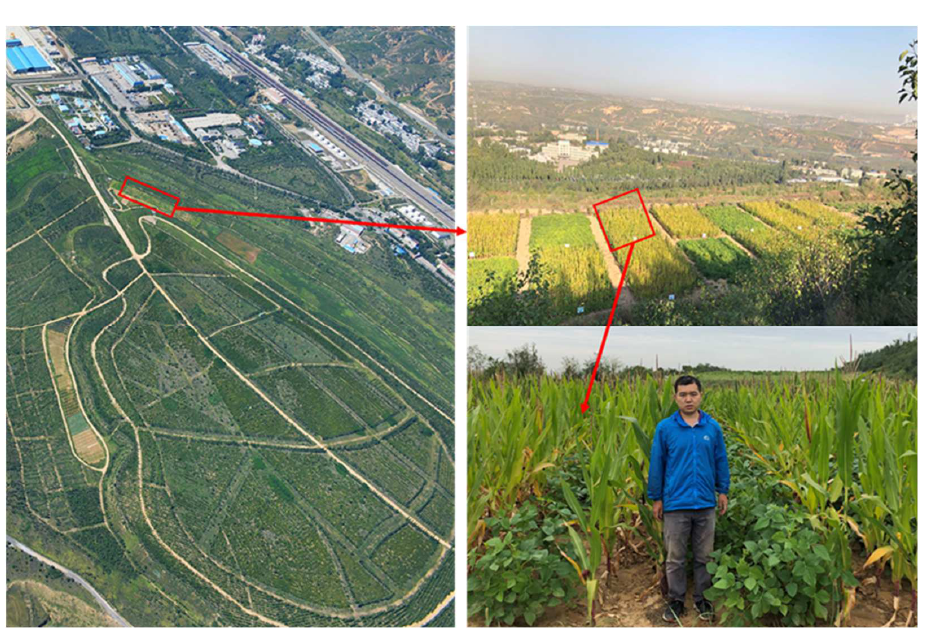
Figure 1. Experimental